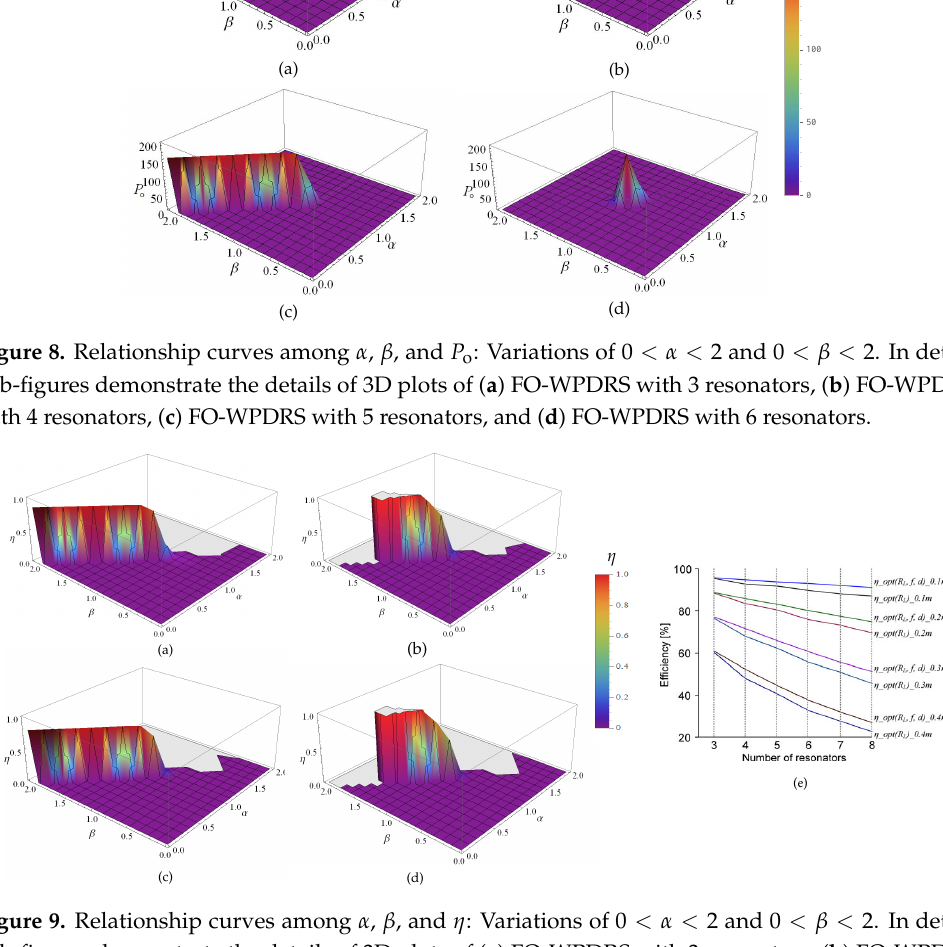
Figure 9. Relationship curves among α , β , and η : Variations of 0 < α < 2 and 0 < β < 2. In detail, Figure 9. 3D plot of relationships among α , β , and P o : Variations of 0 < α < 2 and 0 < β < 2. In detail, sub-figures demonstrate the details of 3D plots of (a) FO-WPDRS with 3 resonators, (b) FO-WPDRS sub-figures demonstrate the details of 3D plots of ( a ) FO-WPDRS with 3 resonators, ( b ) FO-WPDRS with 4 resonators, (c) FO-WPDRS with 5 resonators, and (d) FO-WPDRS with 6 resonators. with 4 resonators, ( c ) FO-WPDRS with 5 resonators, ( d ) FO-WPDRS with 6 resonators and ( e ) Efficiency comparison between the domino systems with optimized loads, frequencies and distance ( η opt ( R L , f , d ) ) and the equally spaced systems operating at resonant frequency and with only optimized loads ( η opt ( R L ) ) with four different average distances: 0.1 m, 0.2 m, 0.3 m, and 0.4 m in